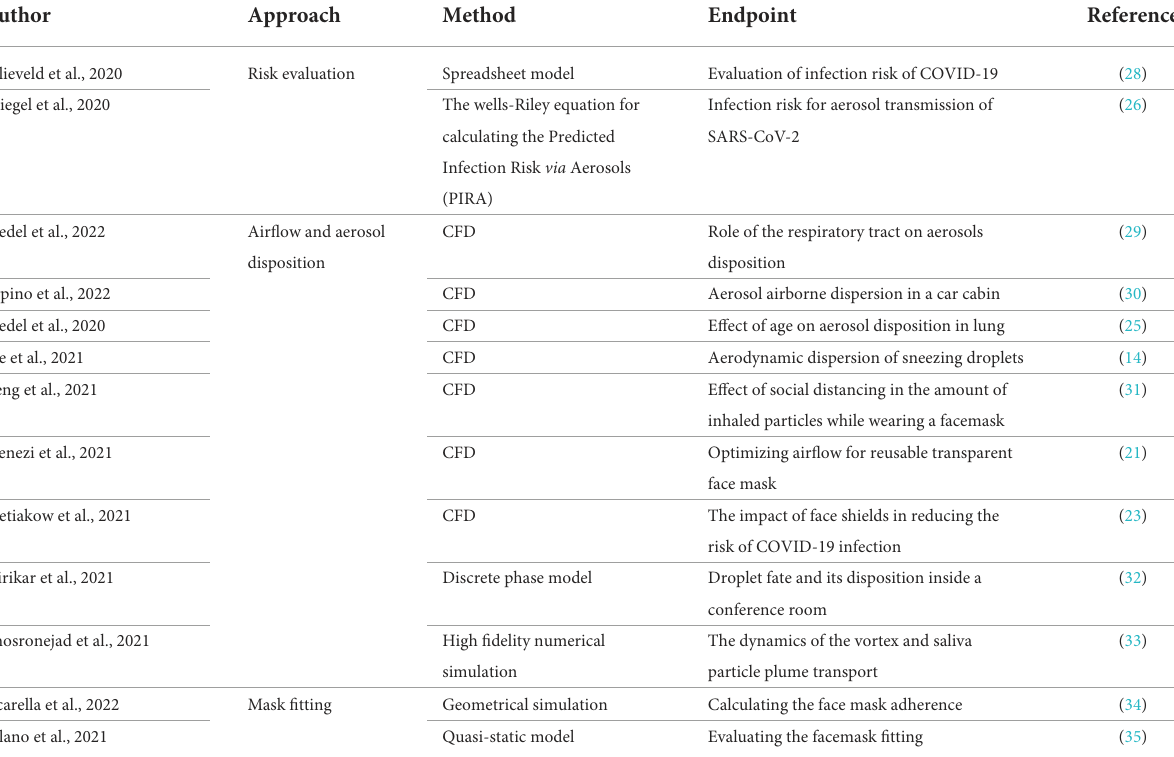
TABLE 1 Summary of some of the recent studies on risk evaluation of COVID-19, aerosol disposition, and mask fitting by implementing computational